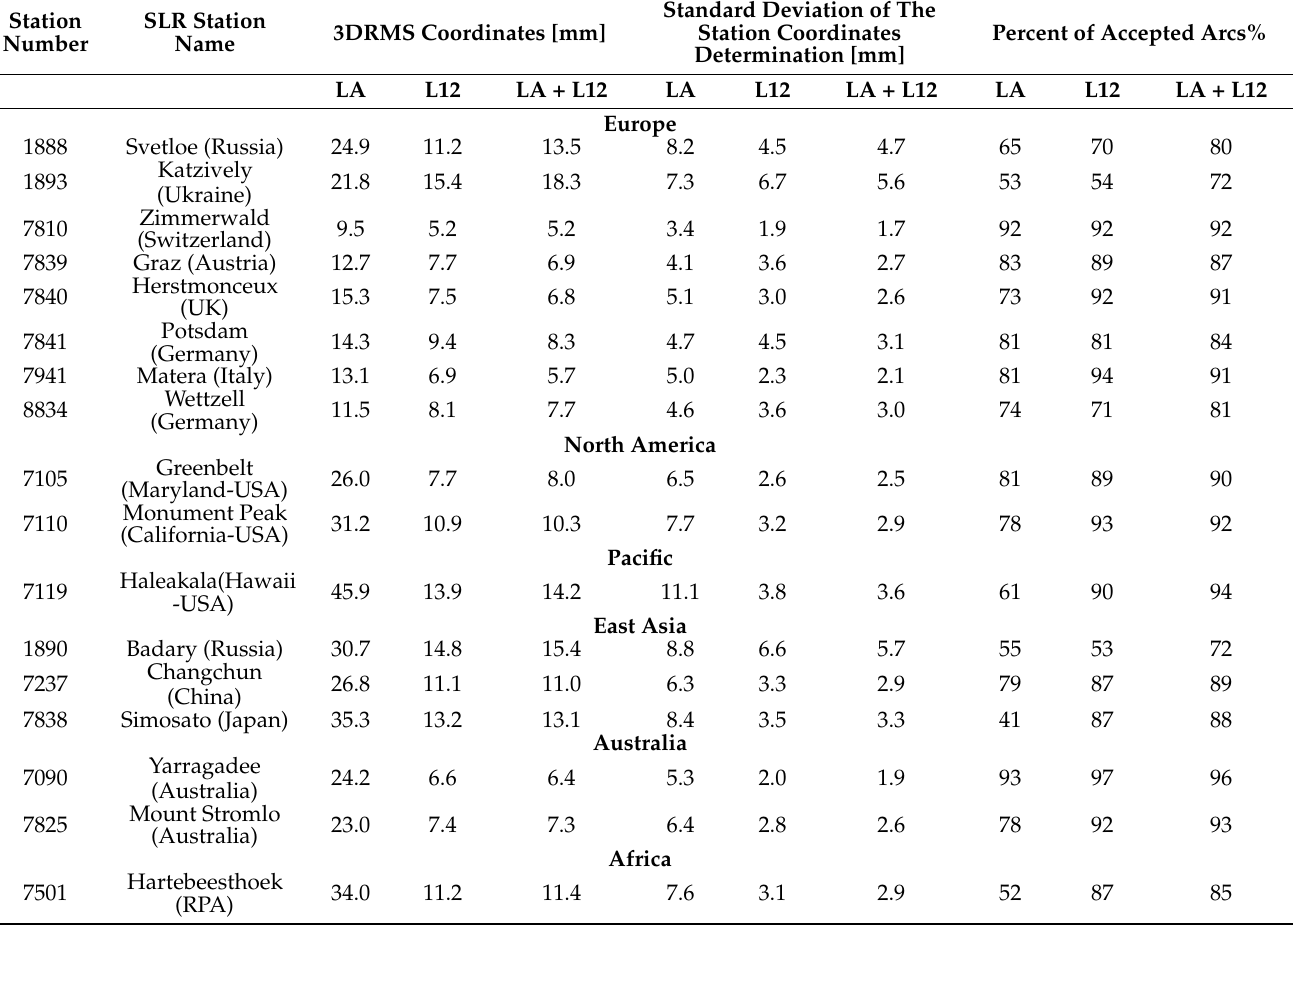
Table 4. LARES-results of station positions determination. LA: LARES, L12: LAGEOS-1 + LAGEOS-2, LA + L12: LARES + LAGEOS-1 + LAGEOS-2.